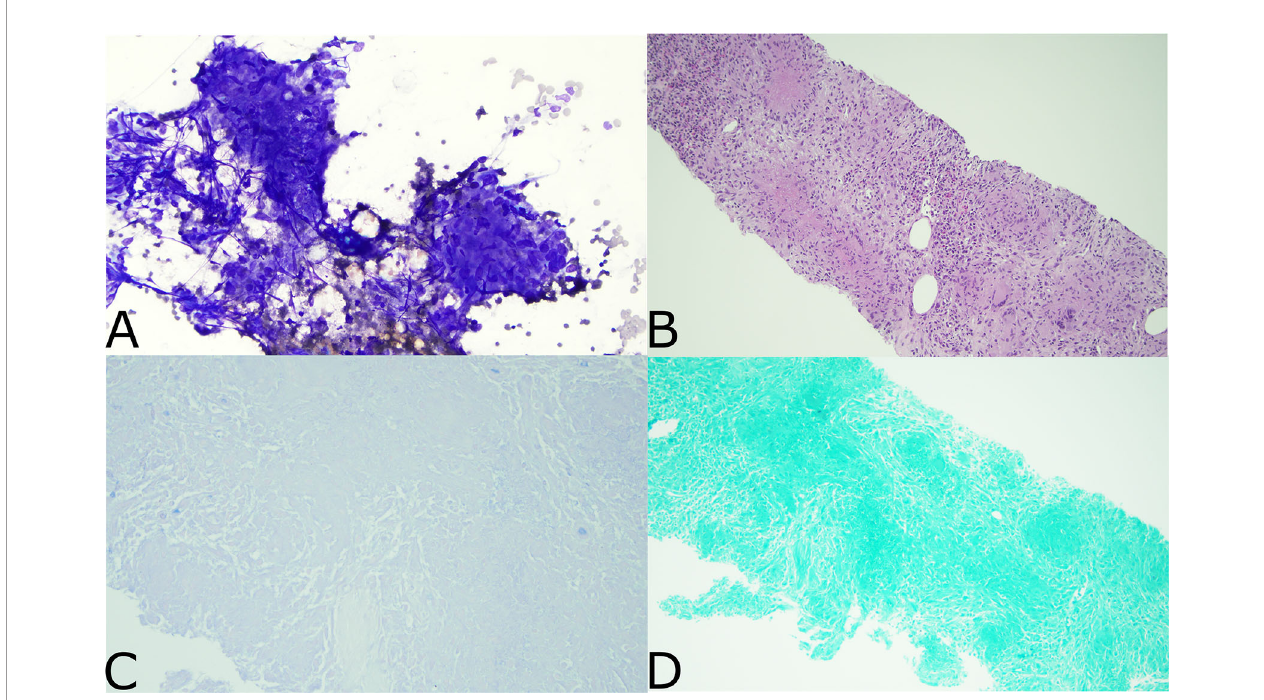
FIGURE 2 | Pathology from Left axillary FNA. (A) Aspirated material of a lymph node shows multiple granulomas. They are charecterized by syncytium cytoplasm and spindled, elongated, carrot shaped and barefoot shaped nuclei (Diff-Quik stain, x200). (B) This small core biopsy shows numerous necrotizing granulomatous in fl ammation effacing the entire lymphoid tissue. The granulomas are characterized by round to oval structures consisting of epithelioid histiocyties with focal central necrosis. Scattered lymphocytes and multinucleated giant cell are noted (H&E stain X100). (C) Ziehl neelsen stain is negative for mycobacterial organisms (Ziel neelsen stain X400). (D) GMS stain is negative for fungal microorganisms (GMS stain